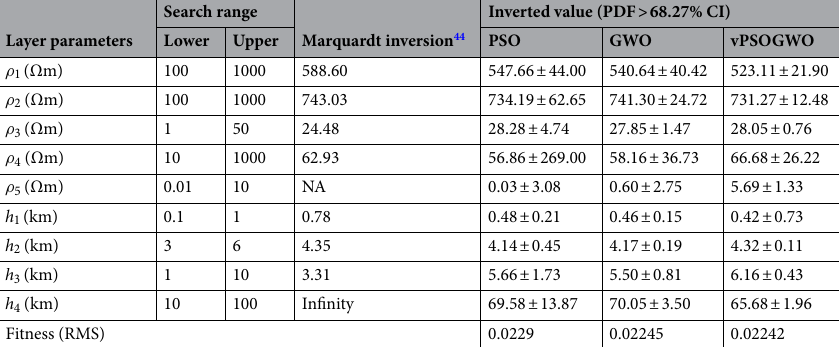
Table 10. Mean model with the level of uncertainty in the posterior utilizing individual inversion of MT data from the findings of the PSO, GWO, vPSOGWO, compared with results inverted by Harinarayana et al. 45 over Western Puga valley geothermal field, Ladakh, India.